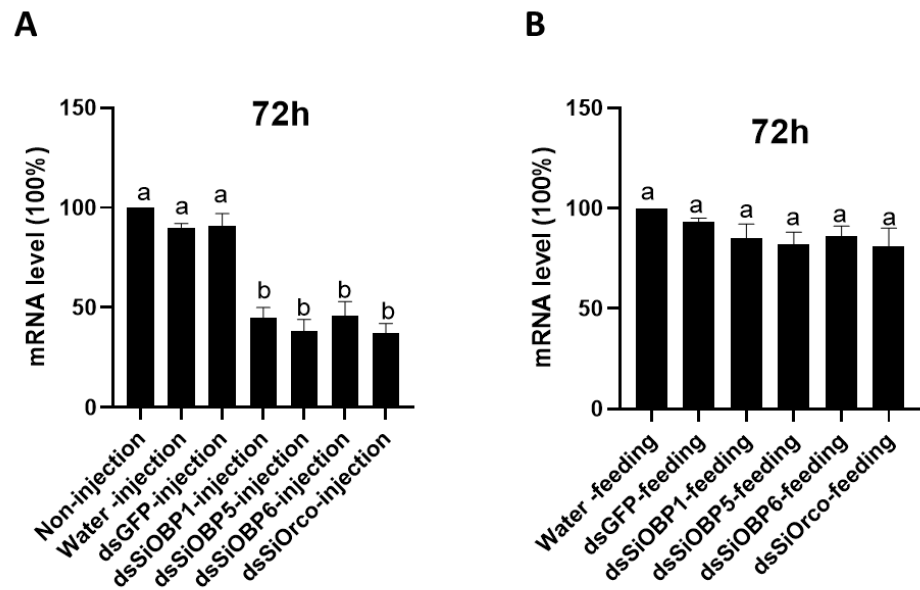
Figure 4. RT-PCR analysis showed a clear reduction in SiOBP1, SiOBP5, SiOBP6, and Orco transcript levels in dsRNA- injected ants. ( A )—mRNA expression levels in non-injected, water-, dsGFP-, dsSiOBP1-, dsSiOBP5-, dsSiOBP6- and dsSiOrco-injected ants 72 h post injection. ( B )—mRNA expression levels in sucrose-water-, dsGFP-, dsSiOBP1-, dsSiOBP5-, dsSiOBP6- and dsSiOrco-fed ants 72 h post feeding. The different letters on the top of the bars indicate statistically significant differences, as determined by one-way analysis of variance with the least significant difference (LSD) test, with significance set at p < 0.05.